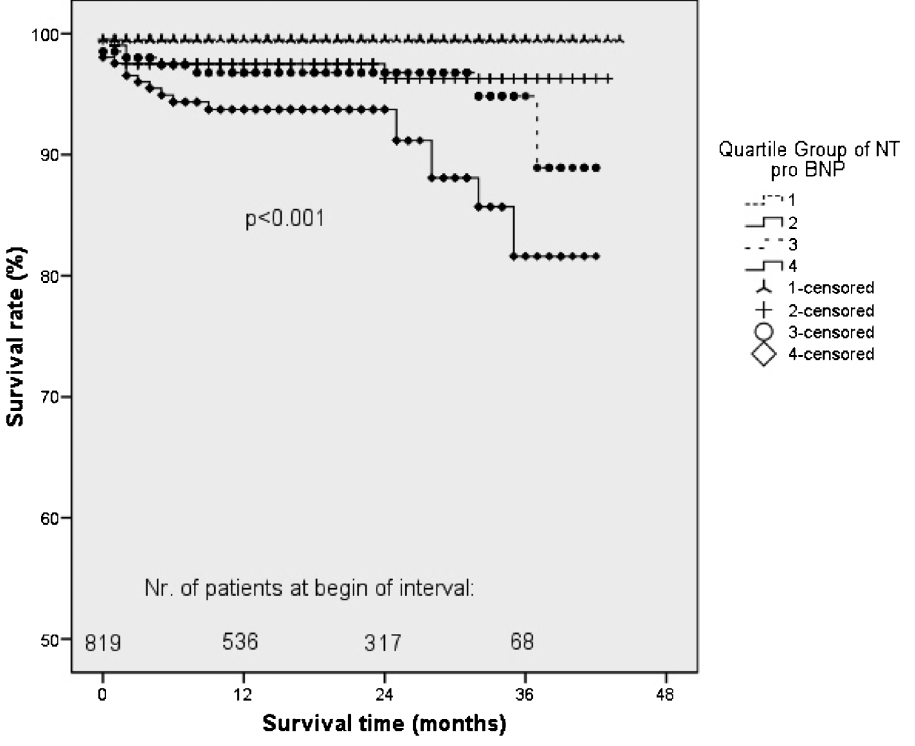
Figure 3 – Mid- term survival of coronary artery bypass patients stratified by quartiles of preoperative N-terminal pro-brain type natriuretic peptide (NT-proBNP)